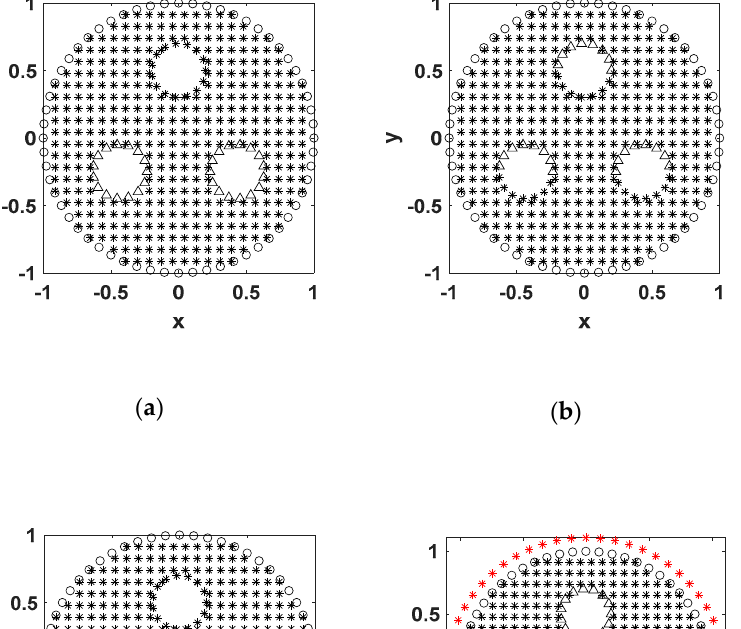
( d ) Figure 16. Contour plots of absolute errors (%): ( a ) unknown upper inner boundary; ( b ) three half unknown inner boundaries; ( c ) unknown inner boundaries; ( d ) half unknown outer boundary.